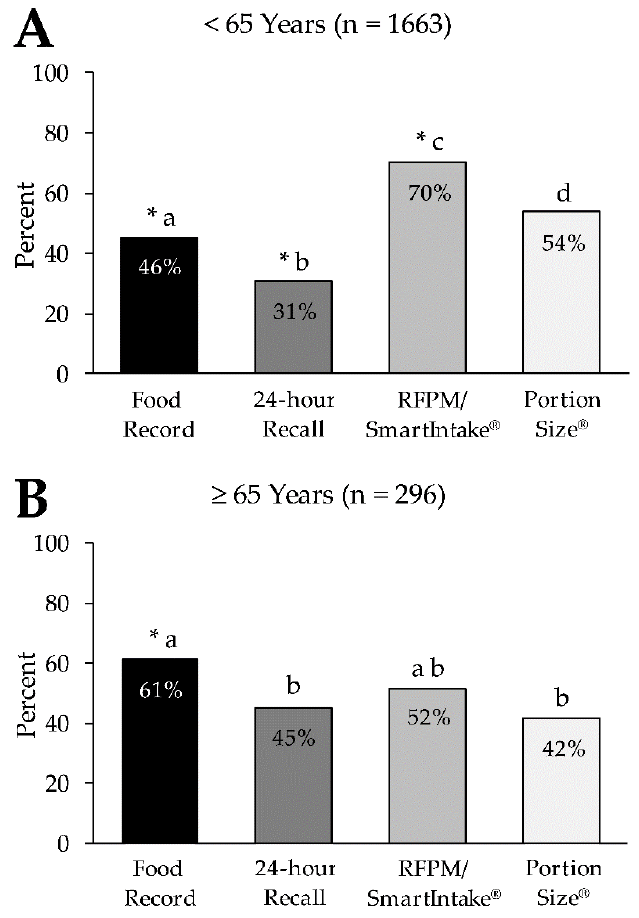
Figure 3. Percentage of participants who rated each method as their preferred method of food intake assessment in those <65 years (Panel A ) and those ≥ 65 years of age (Panel B ). * Denotes a significant difference in ‘not preferred’ for the respective method ( p < 0.001) in the same panel. Letters ( a – d ) that differ from each other indicate differences between methods ( p < 0.001) in the same panel. RFPM, Remote Food Photography Method.